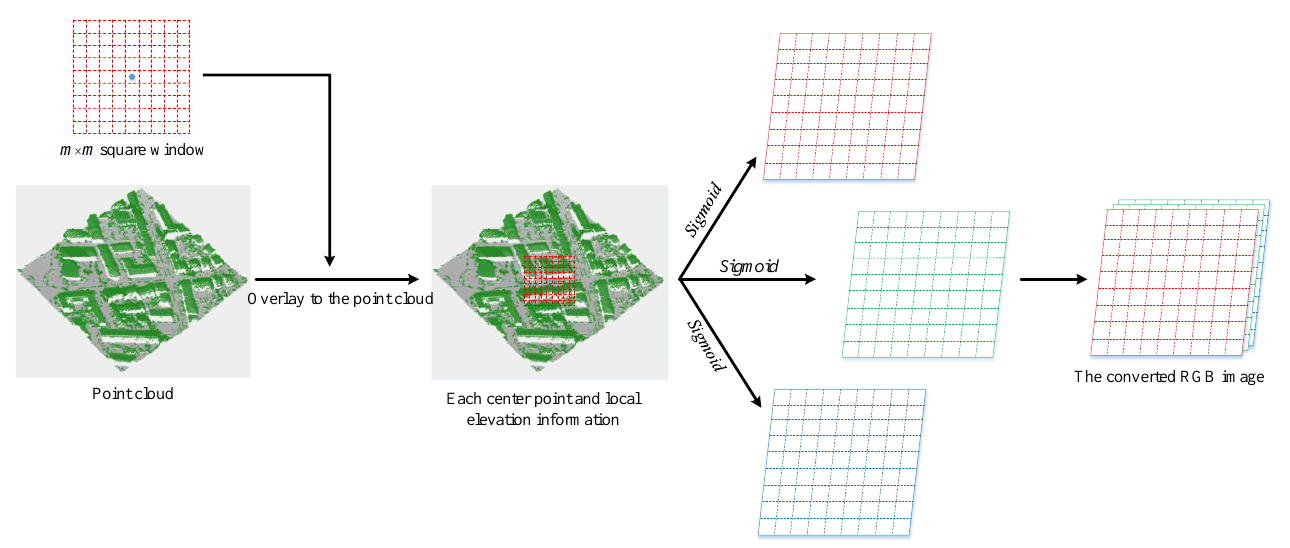
Figure 2. Schematic diagram of converting LiDAR point cloud to RGB image.